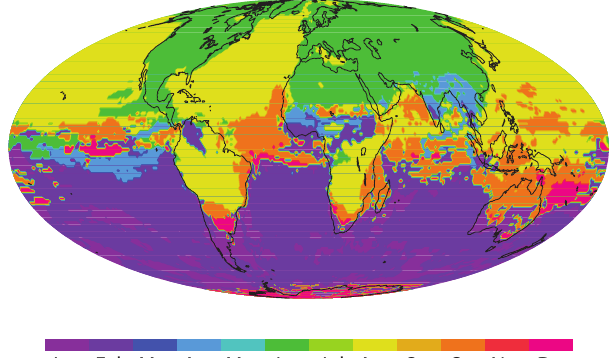
Figure 3. Multi-model mean months of LIG maximum warmth. Month during which 50-year averaged LIG maximum warmth is found. Median of the nine different models is taken as the multi- model mean and for the calculations of LIG maximum warmth we applied the compilation-warmest-periods method, e.g. maximum LIG temperatures per individual grid